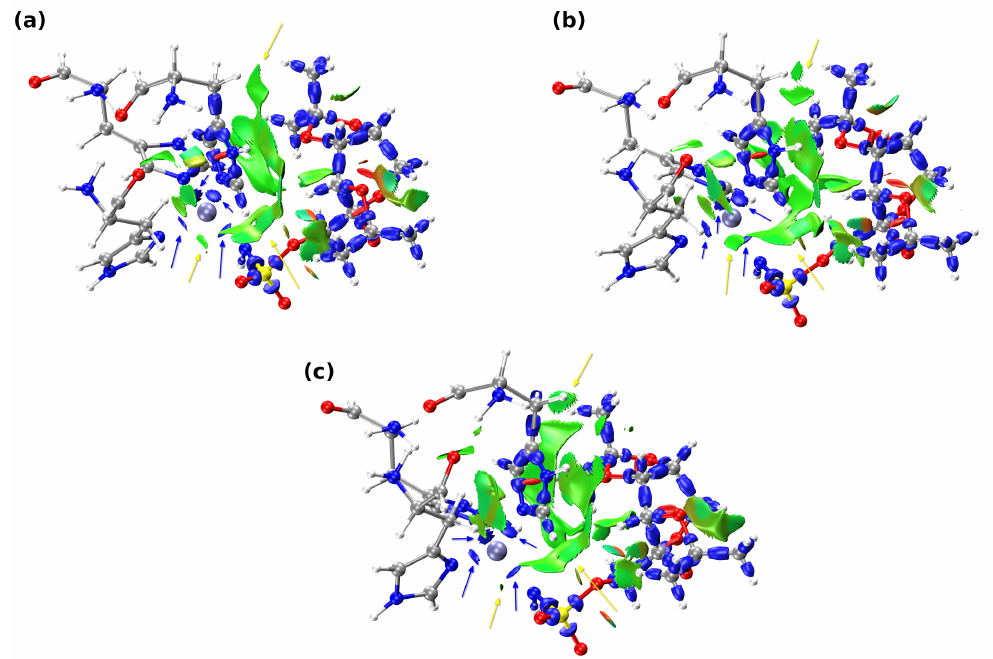
Figure 7. Visualization of the non-covalent interactions, covalent and dative covalent bonds of a small model using the IRI method. Structures were taken from the course of QM/MM Molecular Dynamics. ( a ) Snapshot at 5 ps, ( b ) snapshot at 10 ps, and ( c ) snapshot at 15 ps. All atoms are depicted using the CPK representation. Color coding: grey—carbon, white—hydrogen, red—oxygen, blue—nitrogen, yellow—sulfur, and zinc—iceblue. Selected isosurfaces color coding in the ED range: − 0.035 < sign( λ 2 ) ρ < 0.02